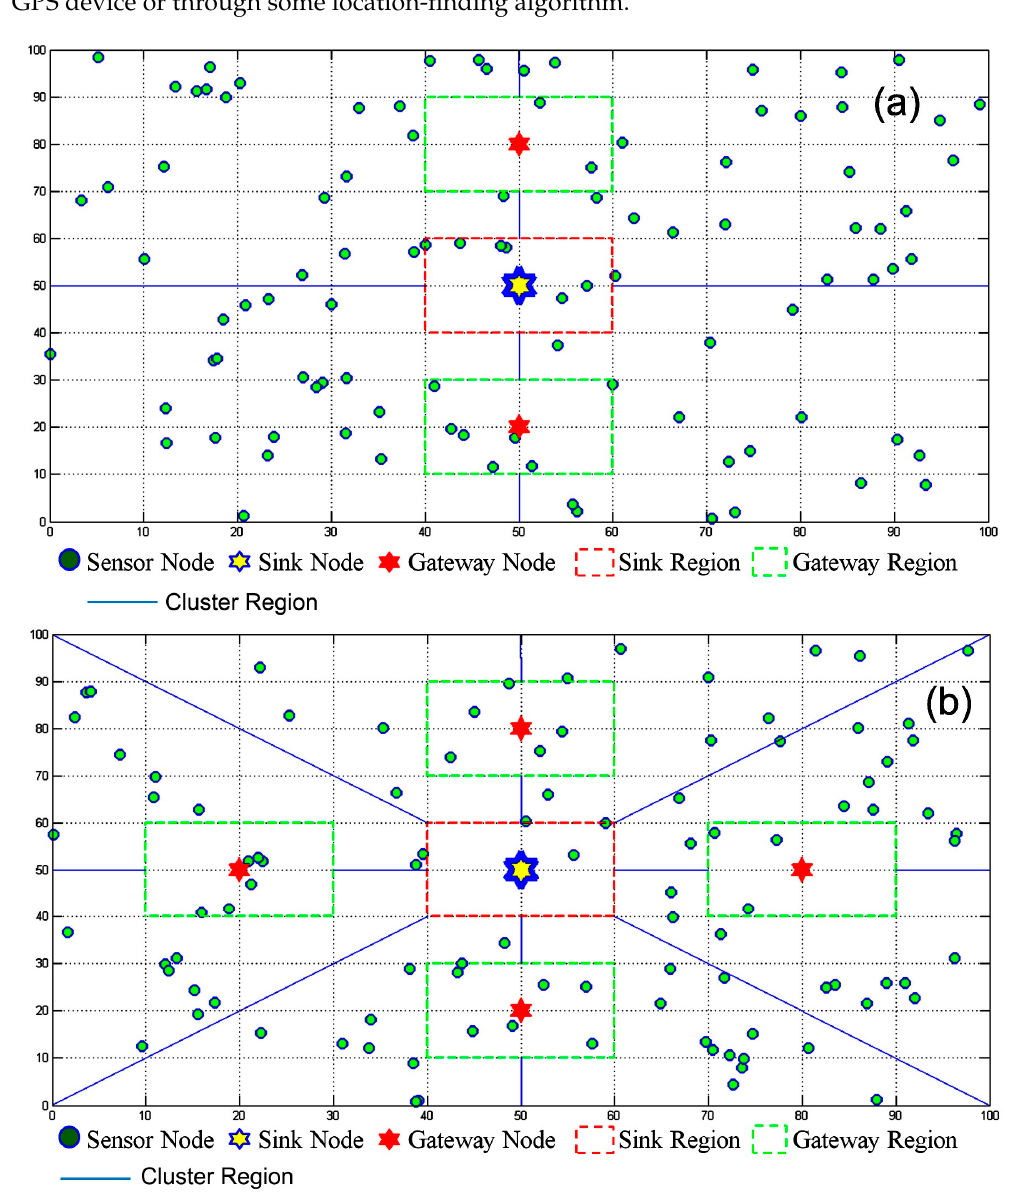
Figure 1. MATLAB view of the MGBEHA protocol with ( a ) two gateways, and ( b ) four gateways.